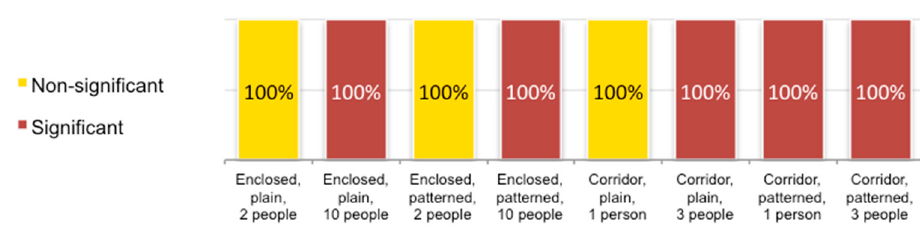
Figure 8. Percentage of participants with significant/non-significant size variations for each space in professional design experience perception filter.